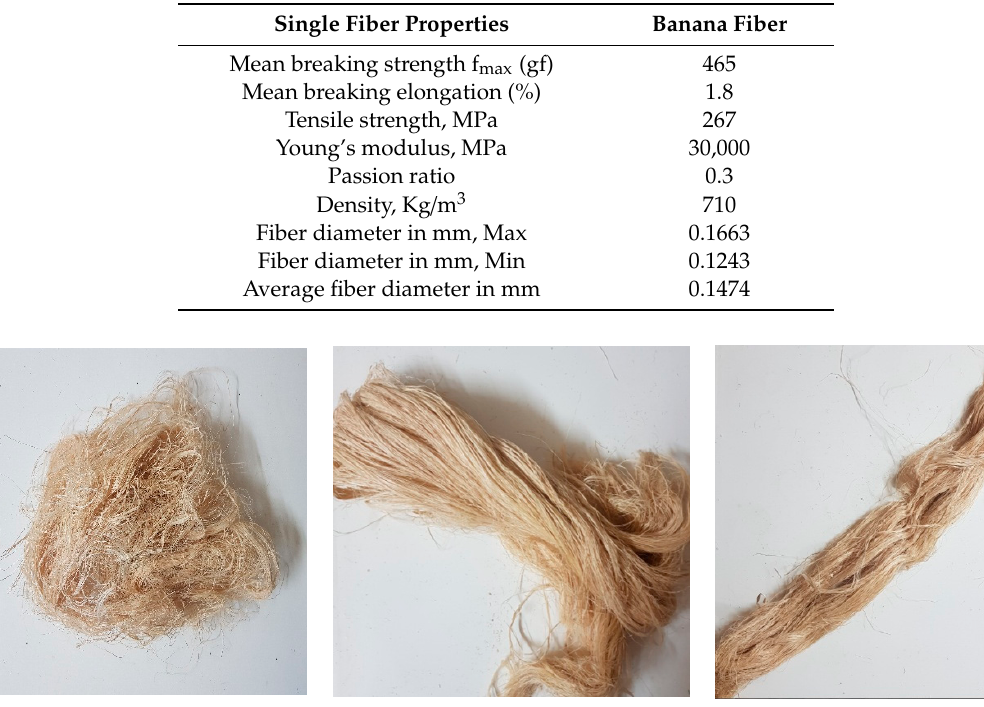
Figure 1. Poovan banana fiber type. Table 1. Mechanical properties of banana fibers